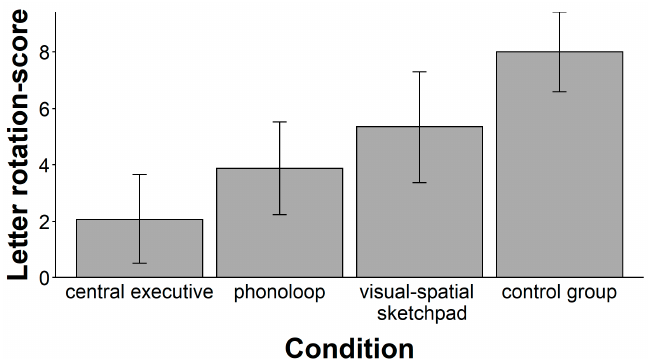
Figure 4. Mean performance in the letter rotation task in the four different groups. Whiskers indicate 95% con fi dence intervals.